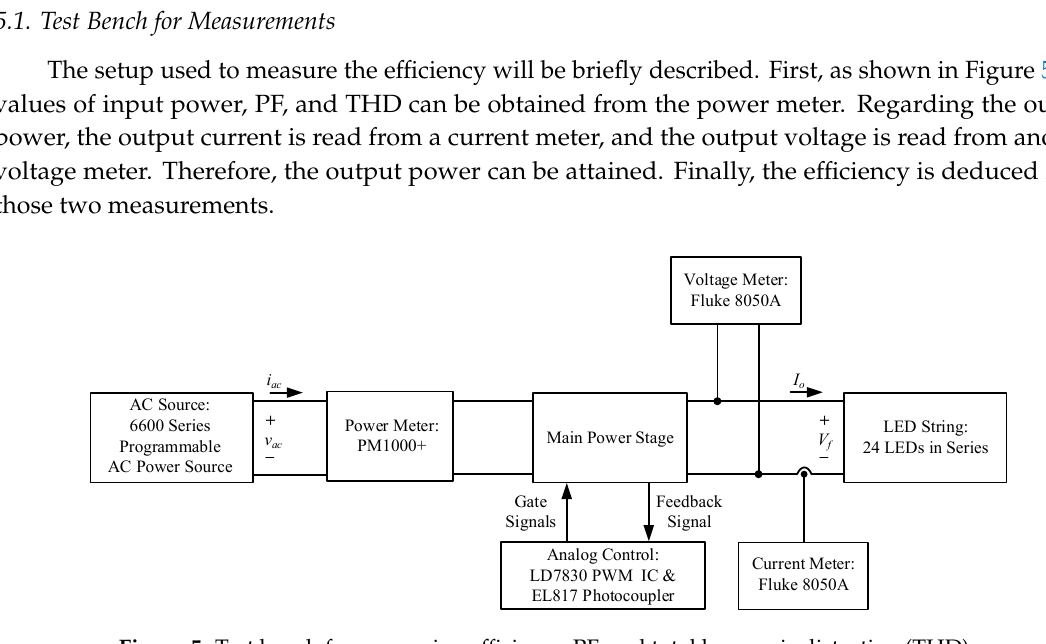
Figure 6. Actual system circuit of the proposed LED driver. 5.3. Measured Waveforms At 110 and 220 V input voltages and 100% output load, some experimental results, without and with the proposed low-frequency current ripple improved, are given to verify the proposed LED driver. Under 110 V input voltage and 100% output load, Figure 7 displays the input voltage v ac and the input current i ac , without and with the proposed method, whereas Figure 8 depicts the ripple of V f , called Δ v f , and the ripple of I o , called Δ i o , without and with the proposed method. Under 220 V input voltage and 100% output load, Figure 9 displays the input voltage v ac and the input current i ac , without and with the proposed method, whereas Figure 10 depicts the ripple of V f , called Δ v f , and the ripple of I o , called Δ i o , without and with the proposed method. Some comments on measured waveforms will be given as follows: (1) For both methods, the higher the input voltage, the larger the input current distortion. (2) For both methods, any value of the input voltage affects the low-frequency output voltage ripple and current ripple slightly. (3) With the low-frequency current ripple improved, not only the output voltage ripple but also